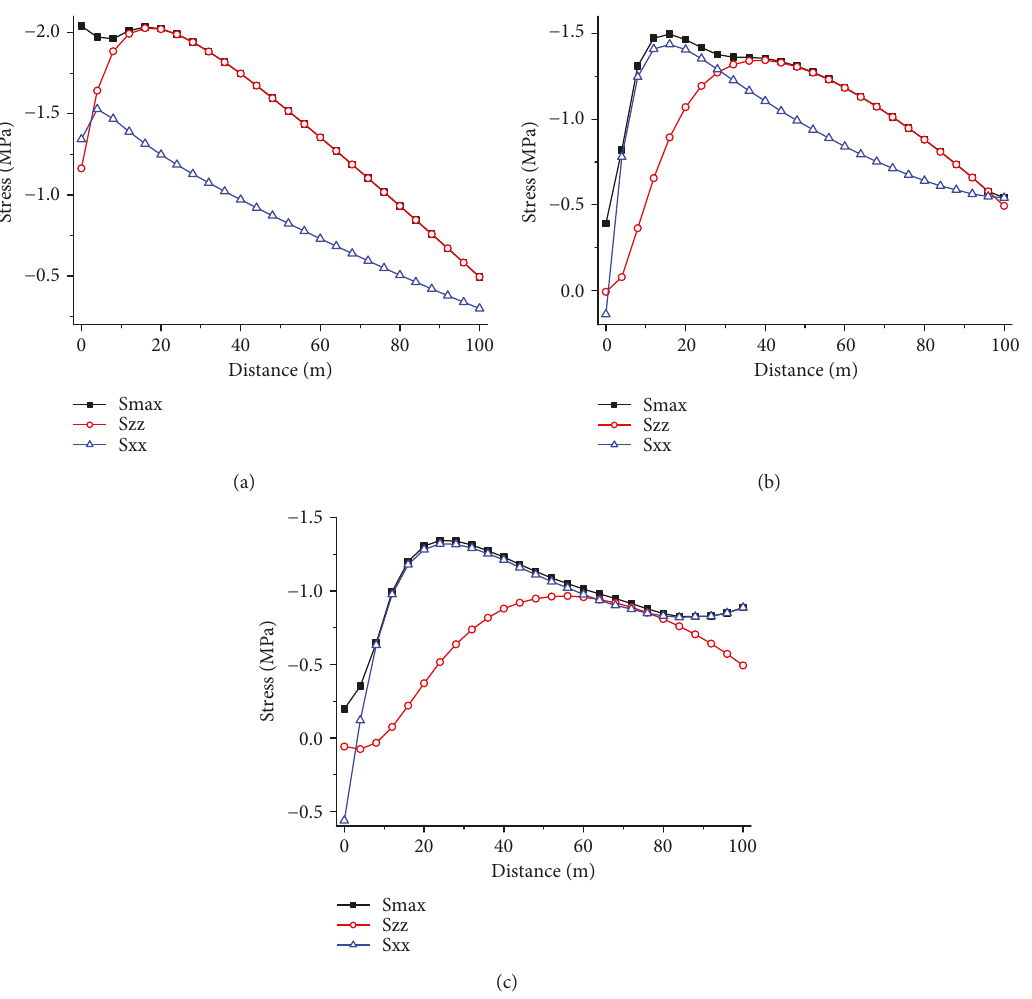
Figure 9: Stress distribution characteristics in the overlying strata. (a) Initial mining stage. (b) The pressure arch in the near fi eld. (c) The pressure arch in the far fi